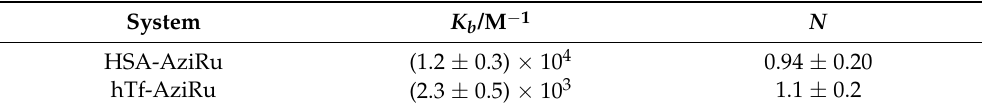
Table 2. Values of the apparent binding constant ( K b ) and stoichiometry ( n ) for the complex formation between AziRu and each serum protein obtained at 20 ◦ C.